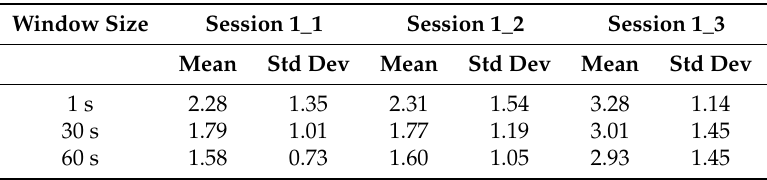
Table 2. Localization error for single-participant sessions, using motion-sensor data only. All the measurements are in meters.